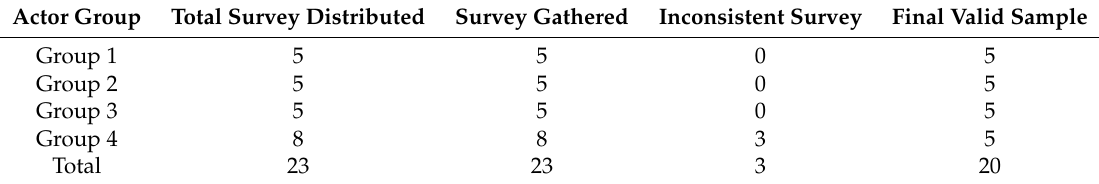
Table 3. Statistics of survey